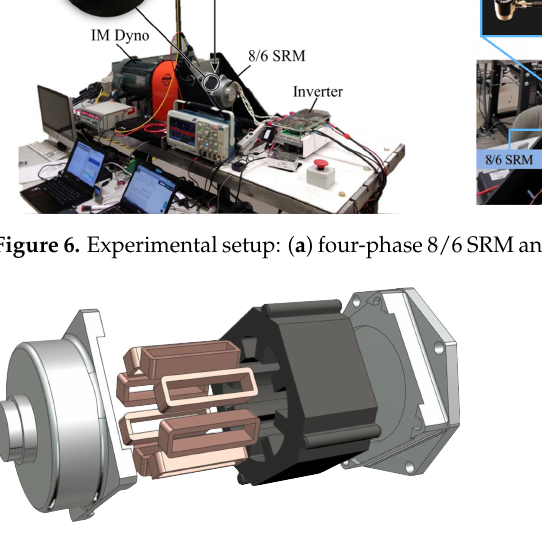
Figure 7. Stator-housing assembly CAD model for the 8/6